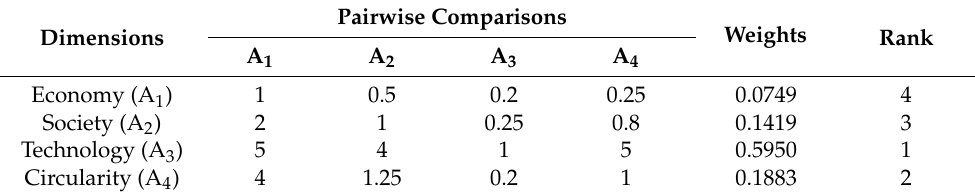
Table 4. The weights and ranking of the four dimensions.